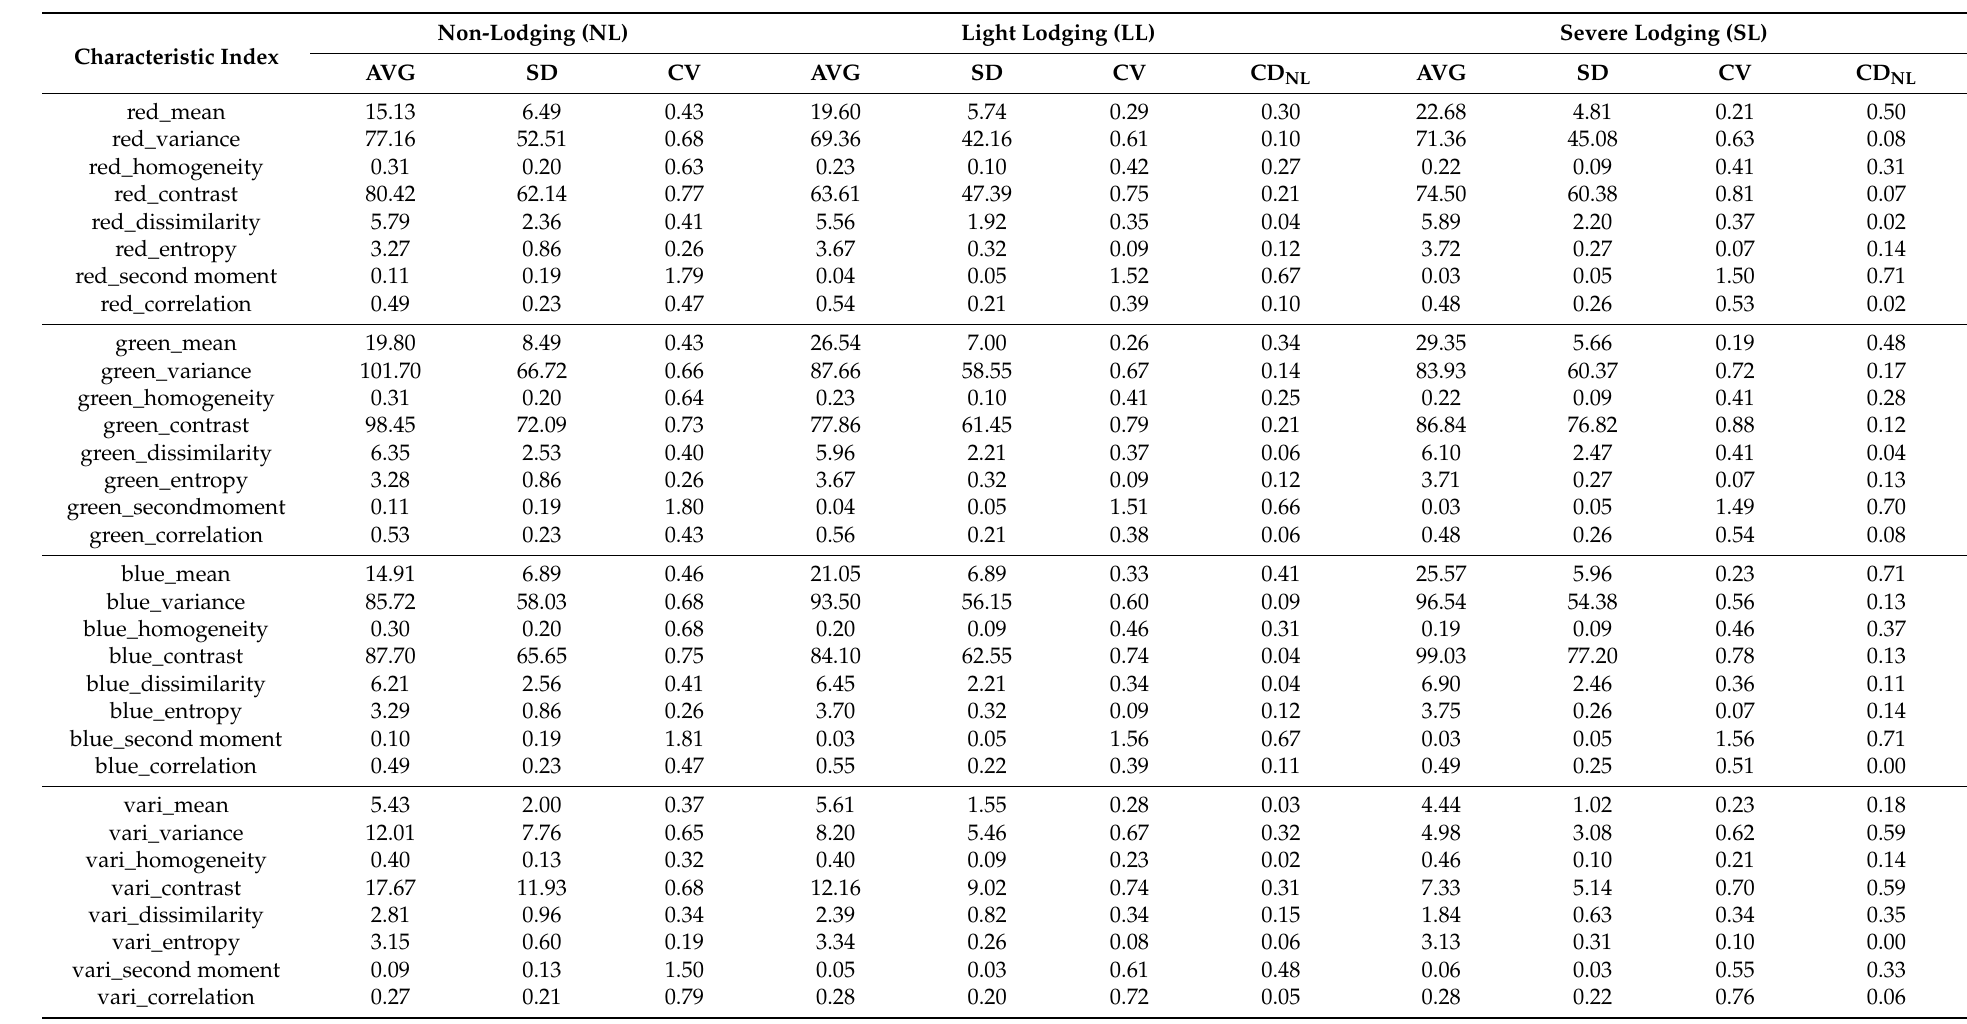
Table A1. Coefficient of variation and coefficient of difference for various degrees of